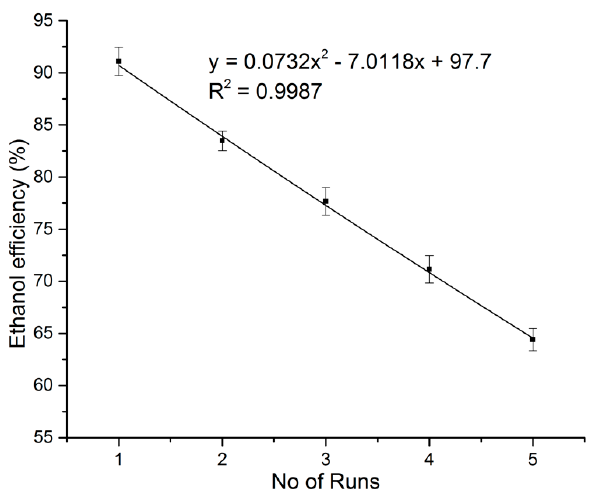
Figure 5. Effect of extraction times on sugar extraction efficiency.